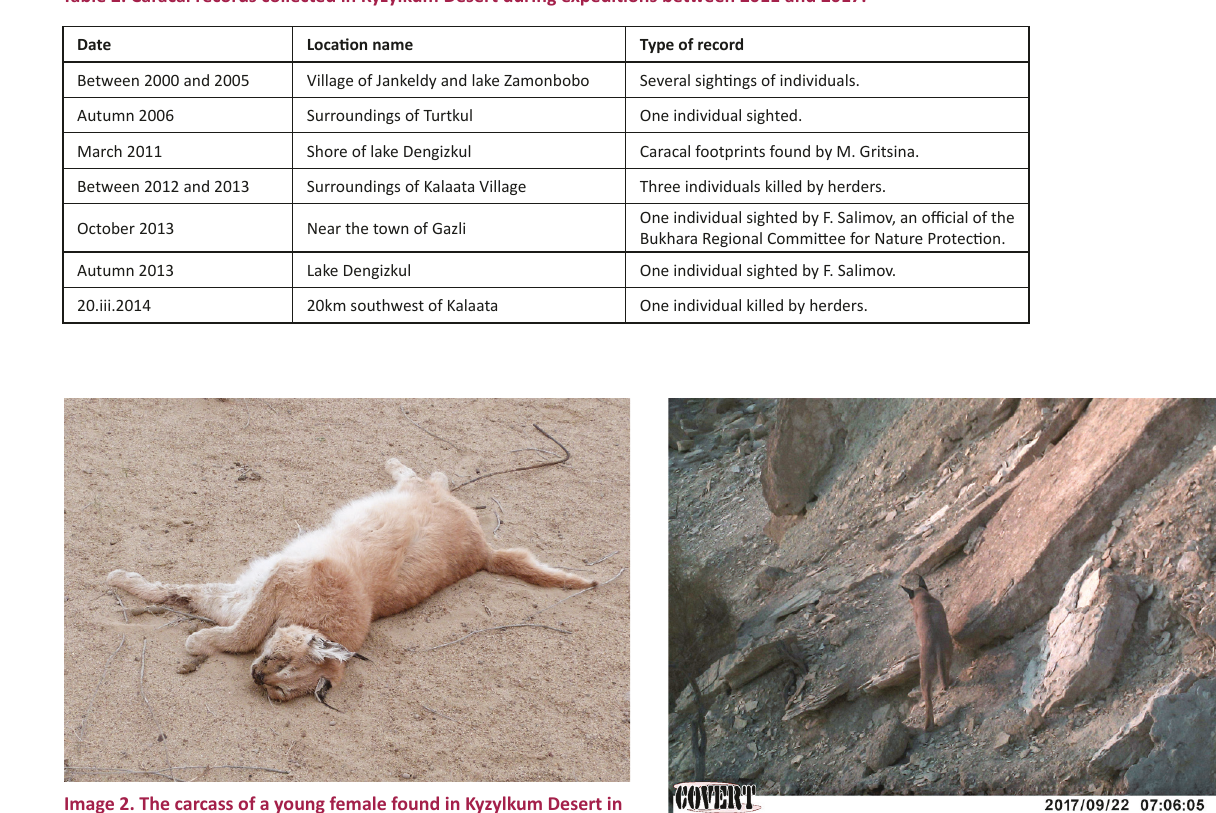
Table 2. Caracal records collected in Kyzylkum Desert during expeditions between 2011 and 2017.